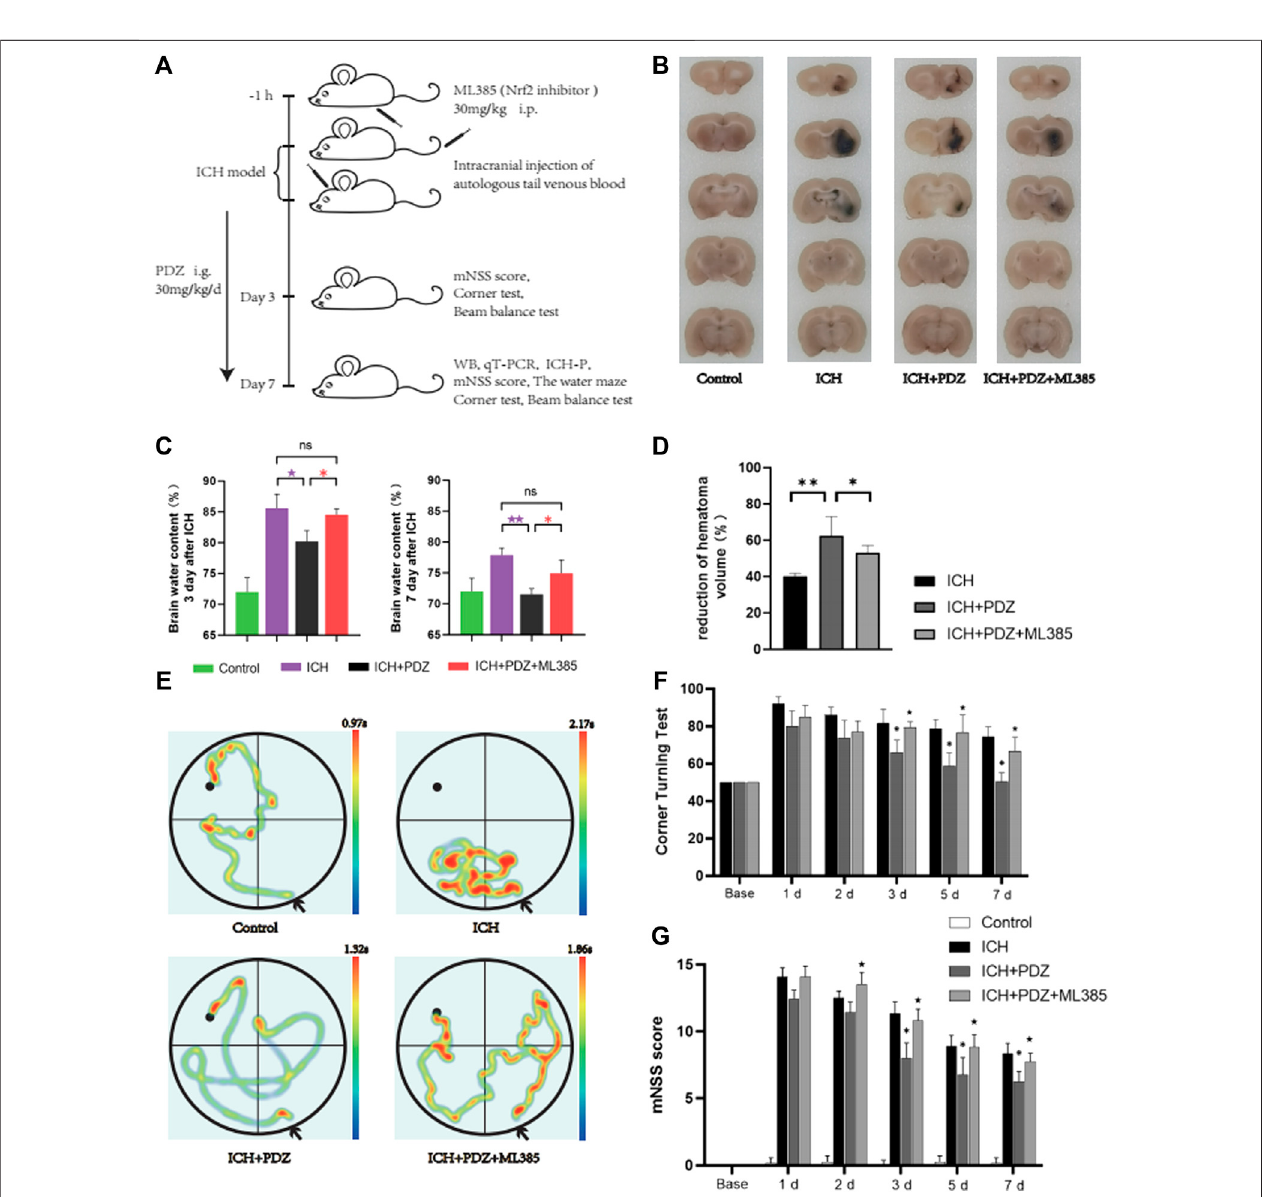
FIGURE 4 | In vivo experimental procedures and evaluation of neurological function. (A) Schematic of the in vivo study. (B) Coronal sections of brain tissue were prepared following sucrose dehydration (5 mm), n = 3 animals/group. The data were obtained from two independent experiments. (C) The cerebral water content was measured 3 and 7 days after ICH. (D) The reduction in the hematoma volume is reported as a percentage. (E) Representative traces of each group in water maze tests. (F) Statisticalanalysisofthe corner turntest. (G) mNSSscoreofrats ineach group. PDZ,pioglitazone. Dataareshown asthemeans ±SD of n =3rats/group,and at least three independent experiments were performed. Statistical analyses were conducted using two-way ANOVA followed by the Newman-Keuls multiple- comparison post hoc test. * p < 0.01, ** p < 0.01. compared with the ICH group. + p < 0.01 and ++ p < 0.01 compared with the ICH + PDZ group.